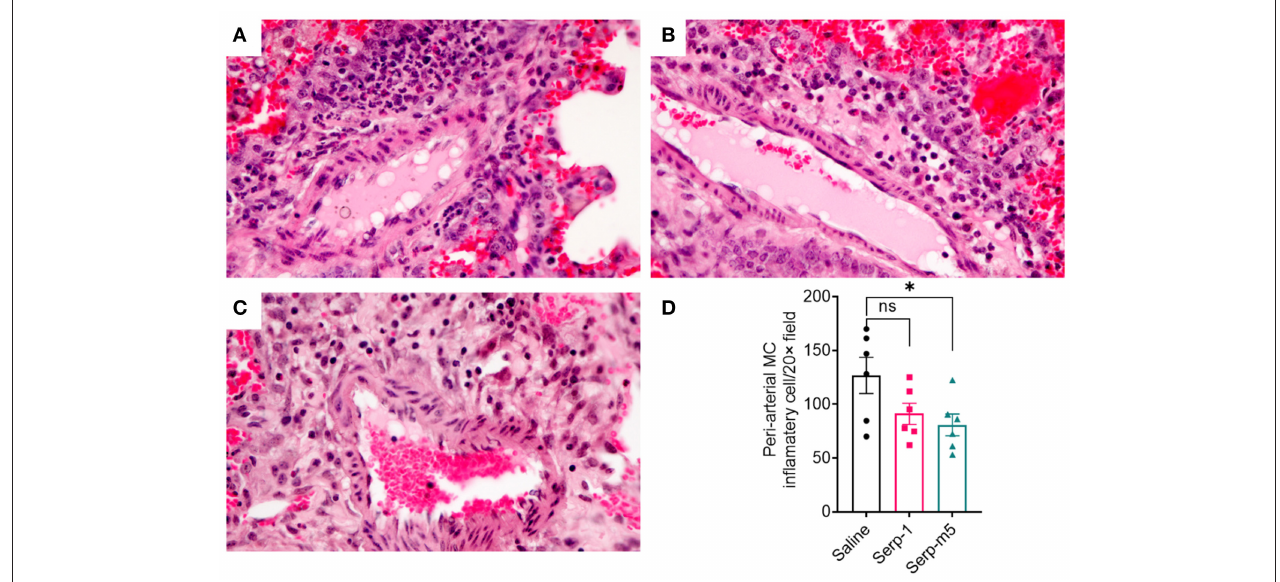
FIGURE 3 | Saline treated mice had marked perivascular mononuclear cell infiltrates after pristane induction DAH (A) . Serp-1 treatment produced a non significant reduction in perivascular inflammatory cell counts (B) . Serp-1m5 treatment significantly reduced perivascular inflammatory cell counts when compared to the saline treated controls (C) . Perivascular mononuclear cell counts ± SEM are illustrated in panel (D) . * p < 0.05.